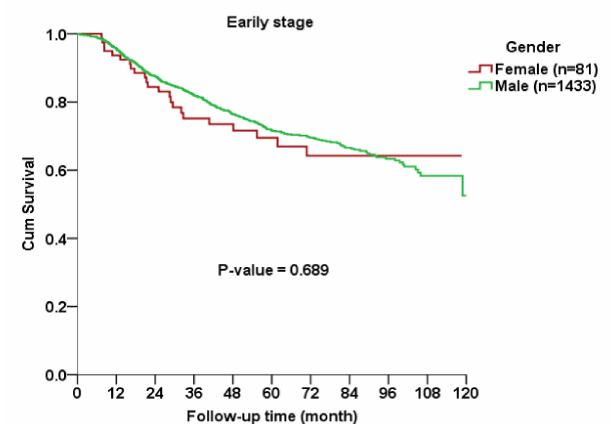
Figure 2. Kaplan–Meier curve for overall survival rates between female and male patients with early-stage oral squamous cell